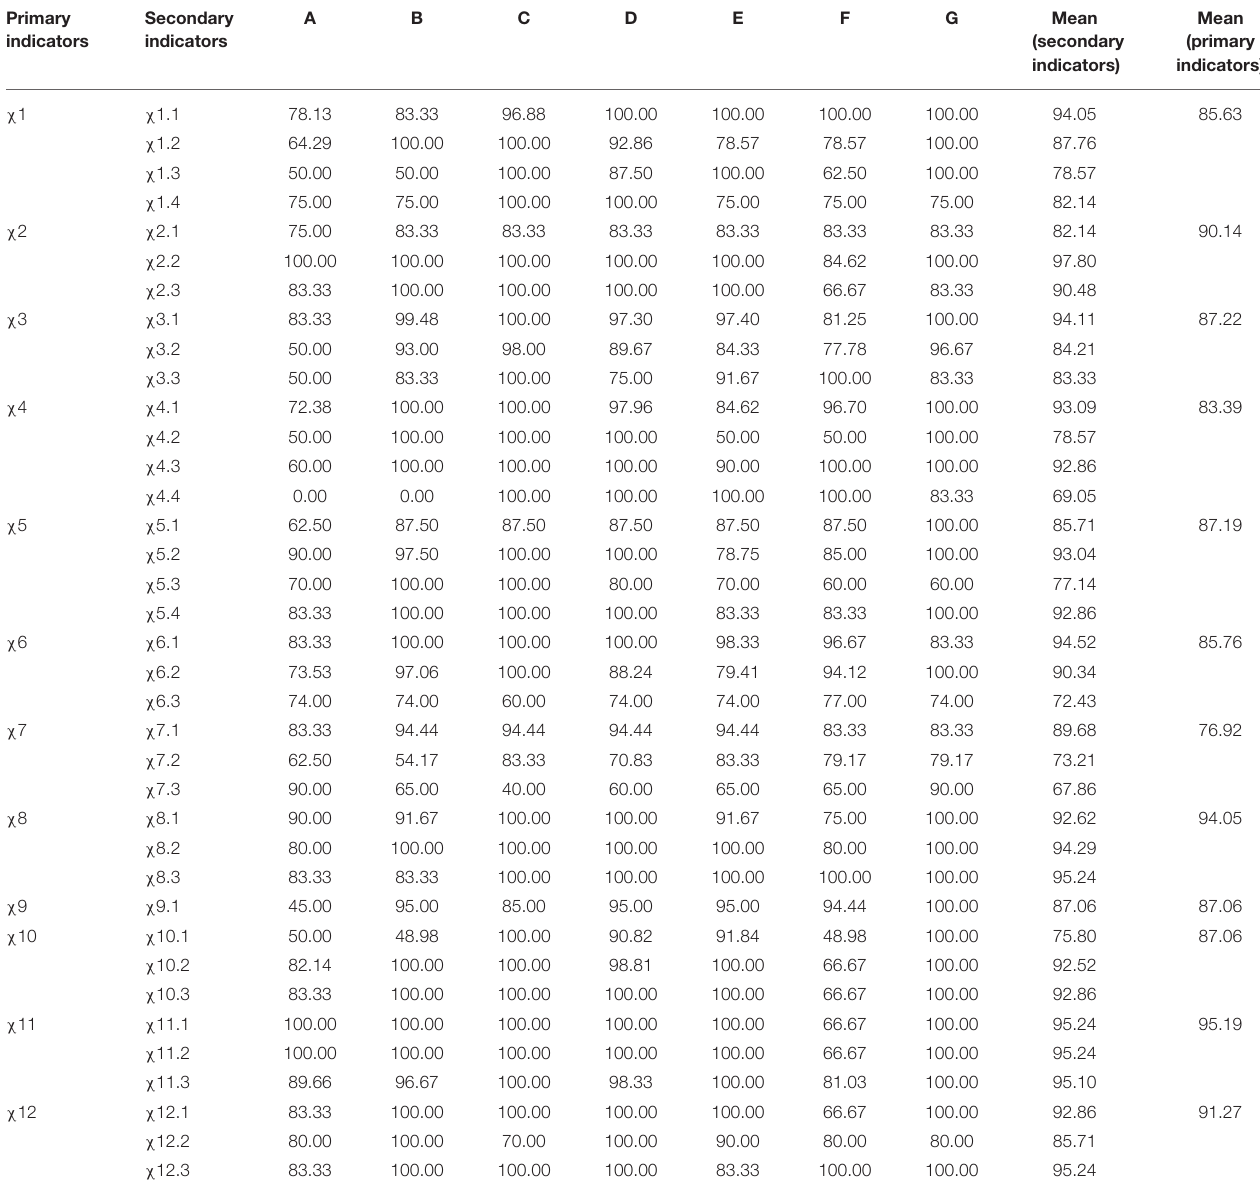
TABLE 2 | Scores for evaluation